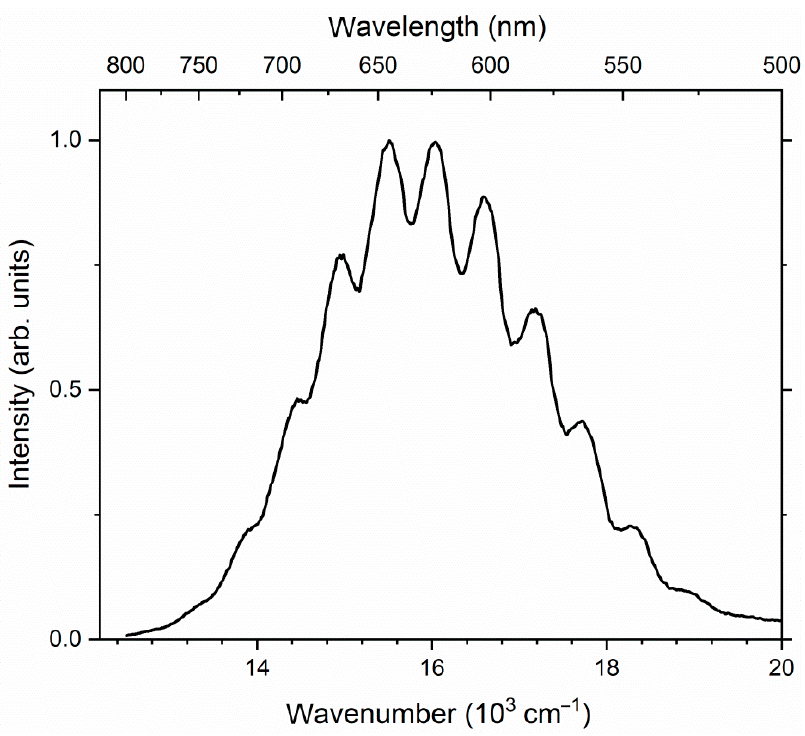
Figure 4. Photoluminescence spectrum of kyanoxalite (Sample 6) upon excitation at a wavelength of 405 nm, measured at a temperature of 77 K. 405 nm, measured at a temperature of 77